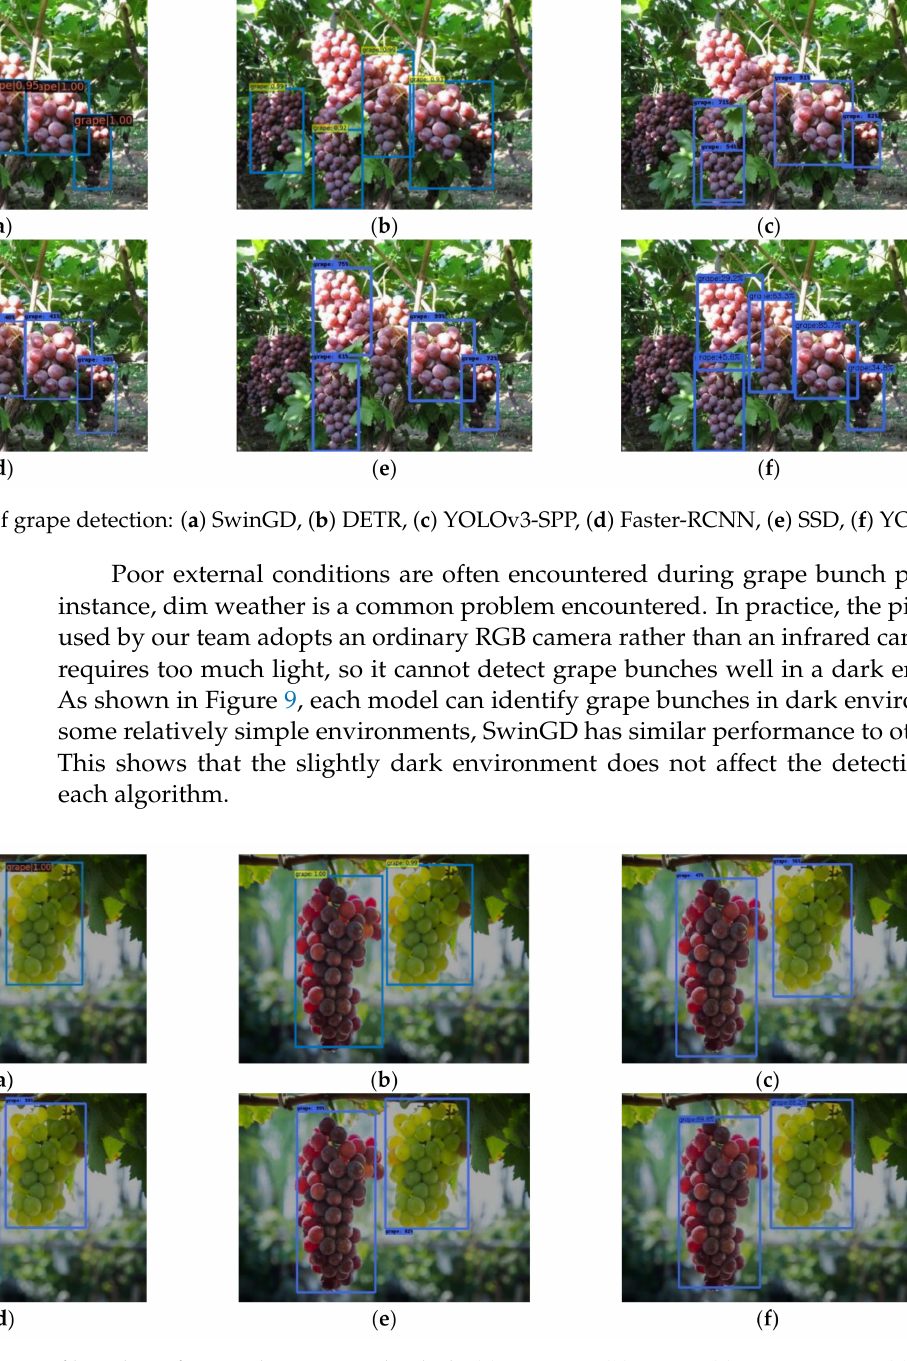
Figure 9. Sample pictures of bunches of grape detection in the dark: ( a ) SwinGD, ( b ) DETR, ( c ) YOLOv3-SPP, ( d ) Faster- RCNN, ( e ) SSD, ( f )